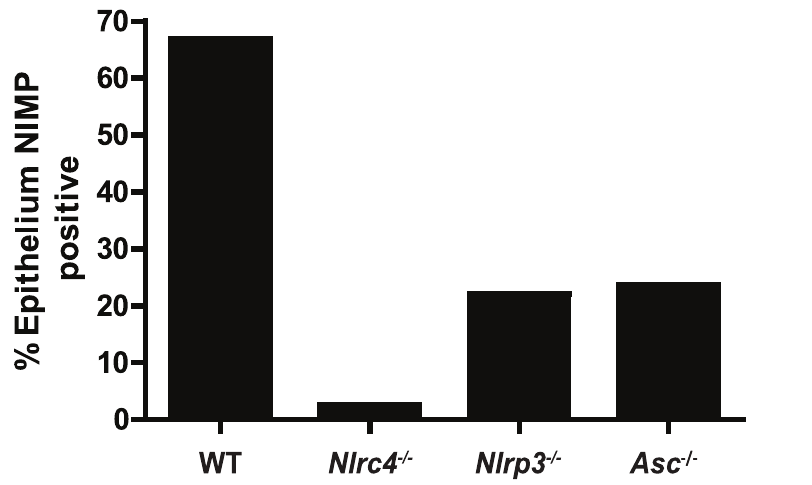
Figure 4. Quantified neutrophil responses in Candida infected epithelium. Neutrophil influx into dorsal epithelium of WT, Nlrc4 2 / 2 , Nlrp3 2 / 2 , and Asc 2 / 2 mice was digitally quantified using MetaMorph software. Shown are percent ratios of fluorescent pixels (representing neutrophil staining) over total pixels within a region containing the dorsal epithelium and submucosa of infected tongues.